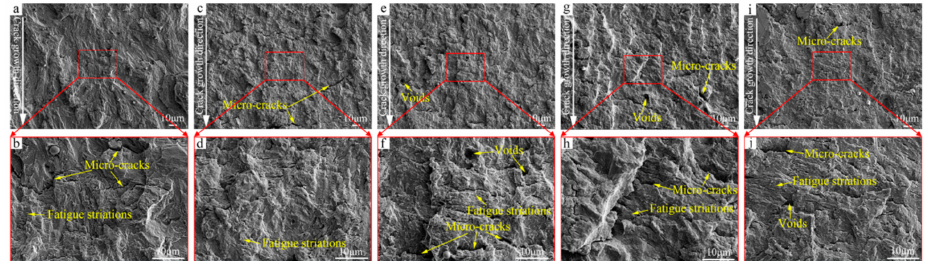
Figure 10. The fracture surface microtopography in the stable growth region: ( a , b ) BM; ( c , d ) HDL; ( e , f ) HDT; ( g , h ) CFL and ( i , j ) CFT. Figure 11 illustrates the fracture morphologies of five specimens in the unstable region.